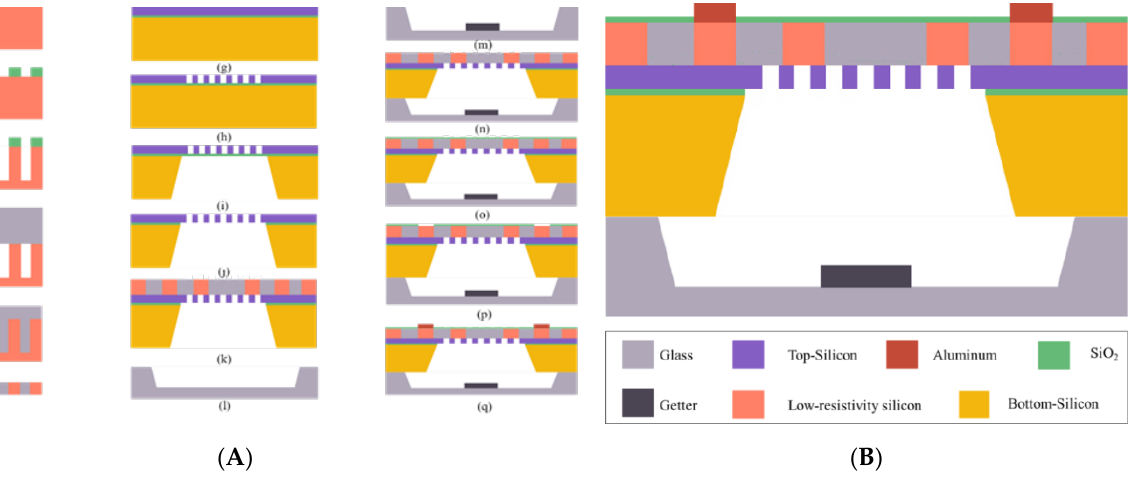
Figure 5. ( A ) The fabrication process of BFVG in 3D wafer-level packaging. ( B ) The device structure of the sensing element.